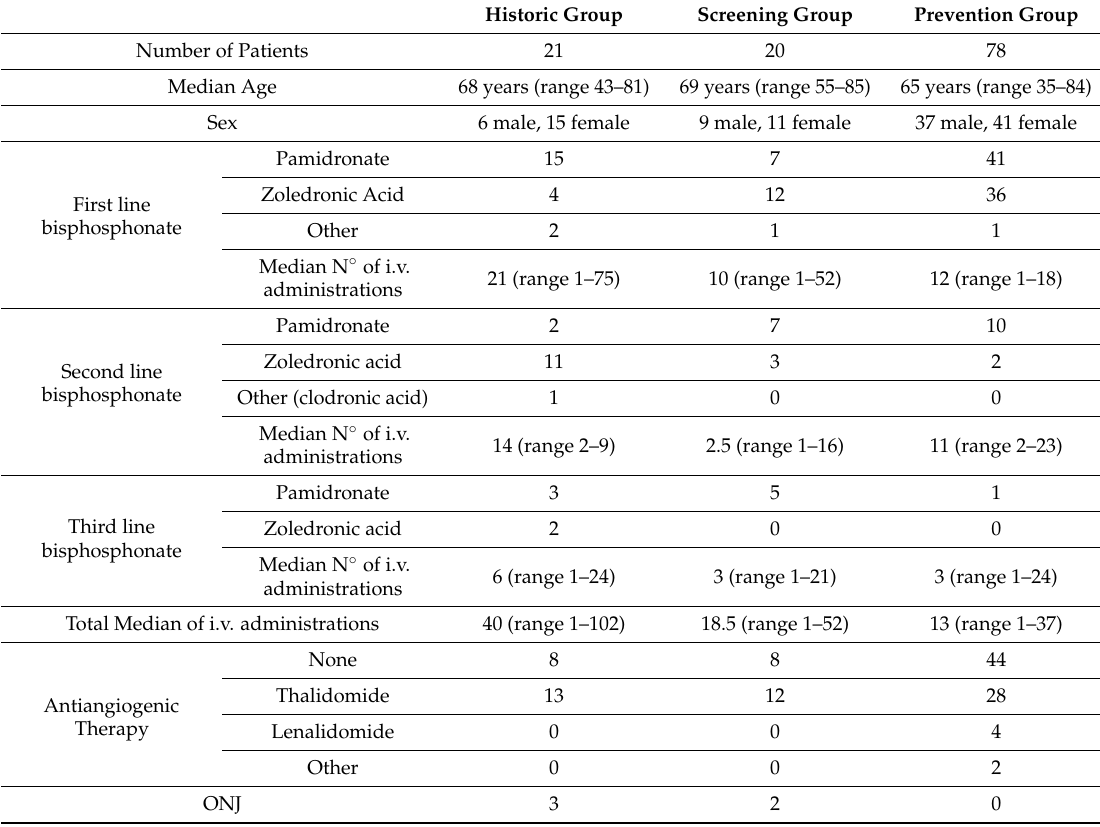
Table 1. Patient